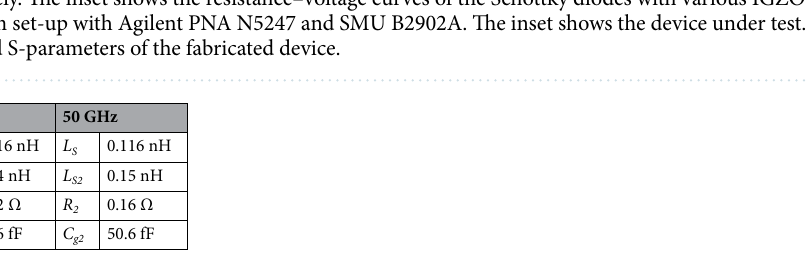
Table 1. Equivalent circuit component value of the proposed SRR at the operational